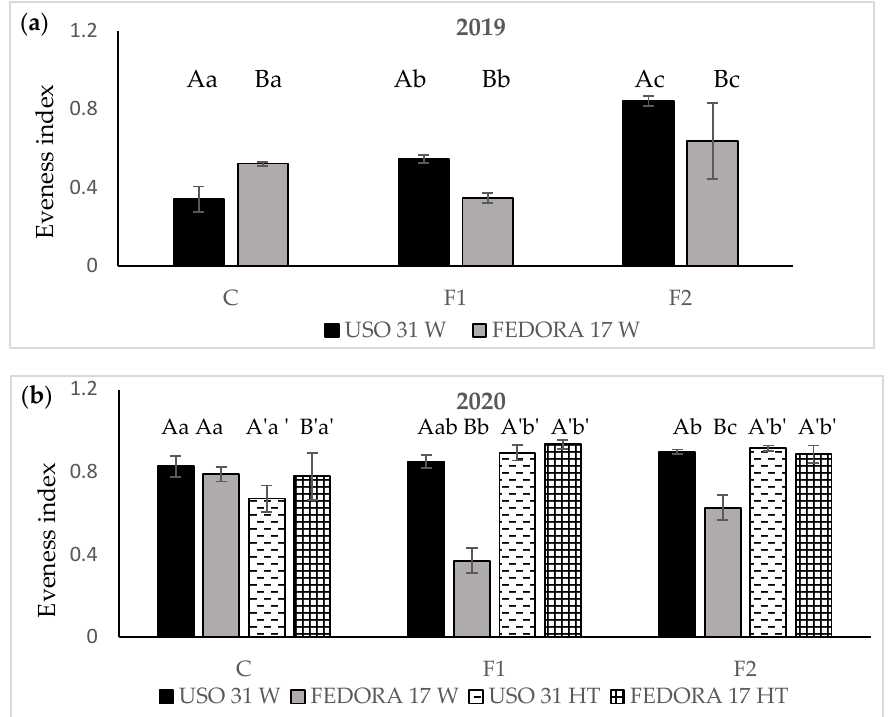
Figure 5. Evenness index of weeds in hemp crop during the growing season 2019 ( a ) and the growing season 2020 ( b ). Vertical bars indicate the standard errors of the means. Values without a common letter are statistically significant according to LSD (0.05).